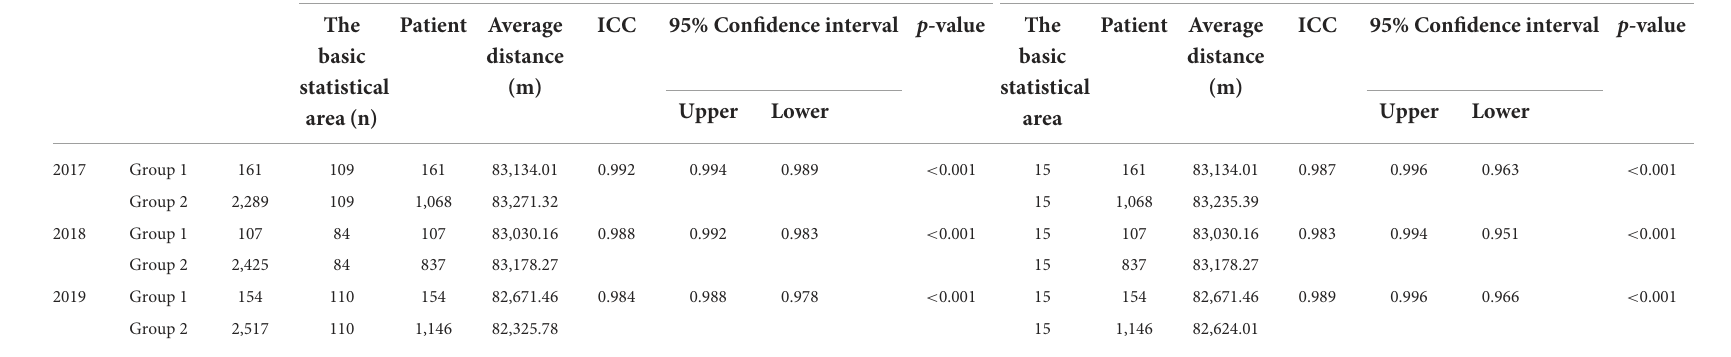
TABLE 6 Predictive accuracy of diabetes (ICC).